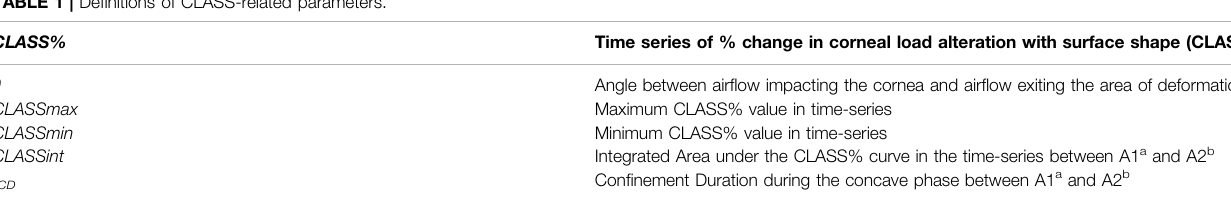
TABLE 1 | De fi nitions of CLASS-related